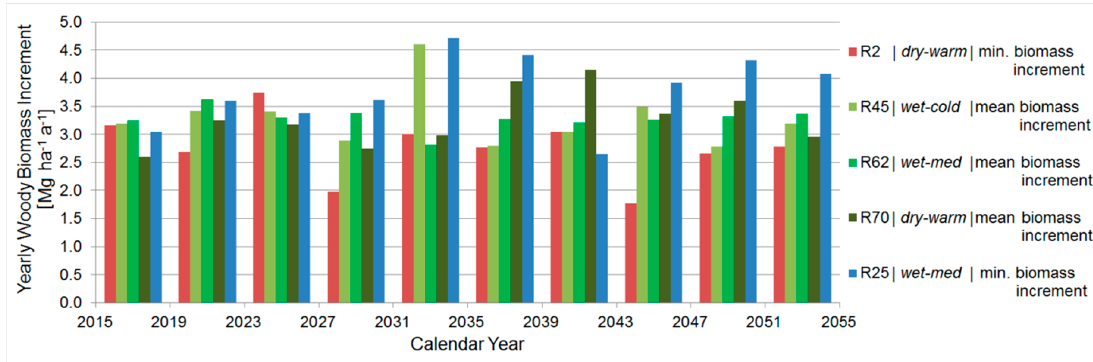
Figure 9. Projected minimum (orange), mean (green), and maximum (blue) yearly woody biomass increment of black locust trees with respect to the ten established growing periods.